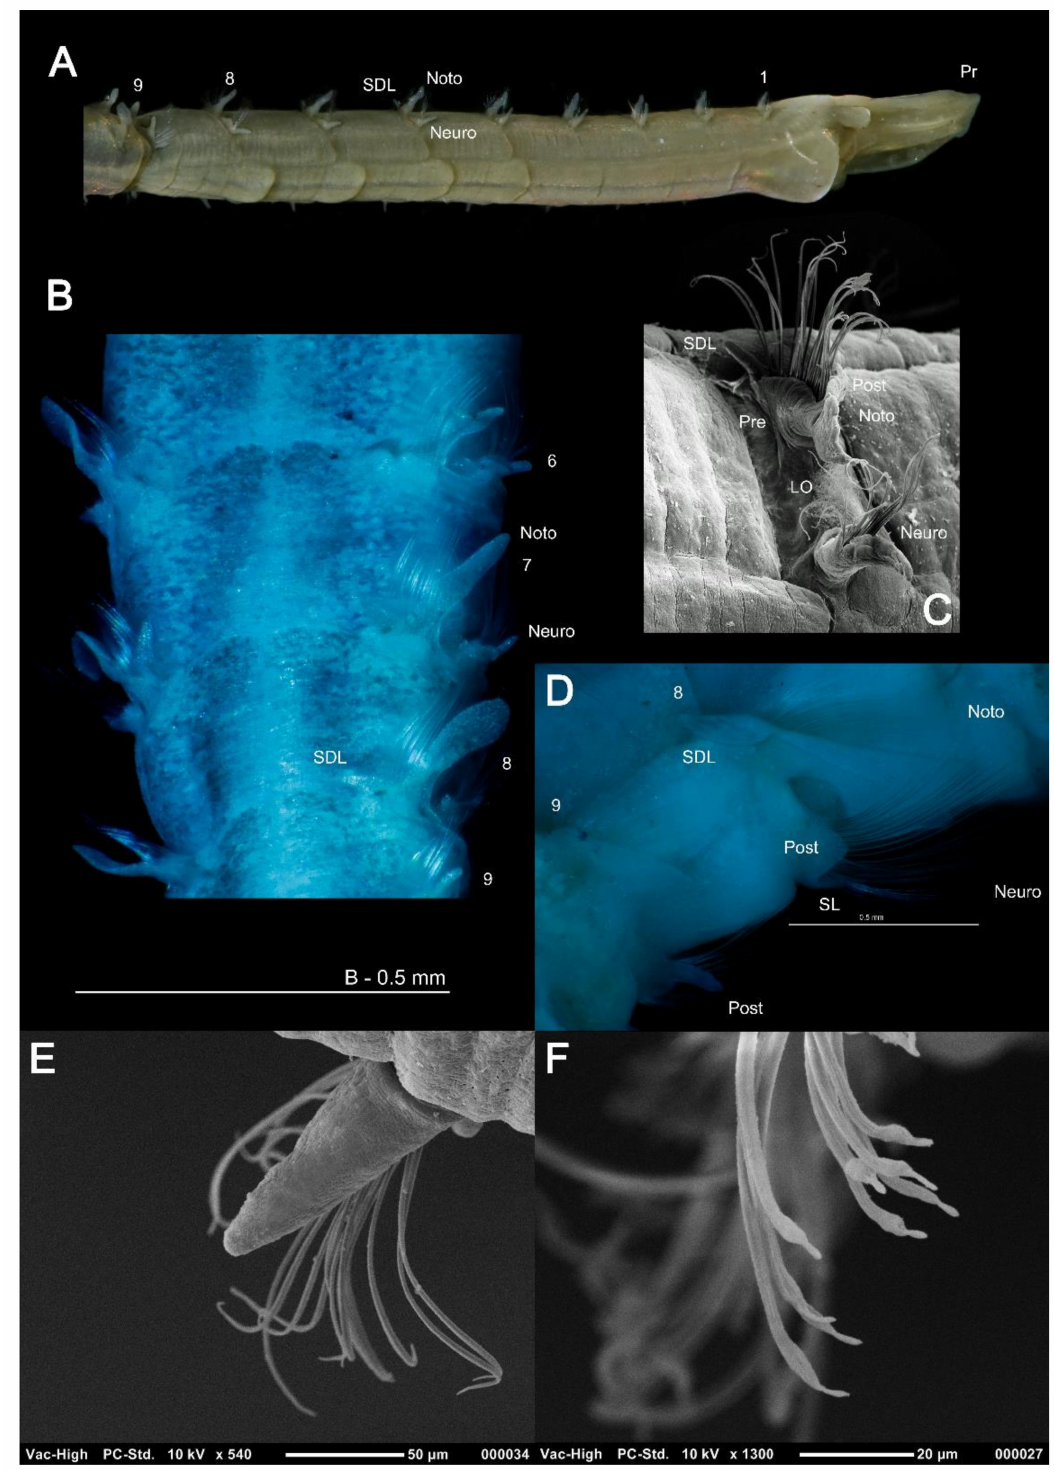
Figure 5. Thoracic parapodia and chaetae: ( A ) anterior of Magelona filiformis (lateral view) showing filiform lamellae; ( B ) M. crenulifrons from chaetiger 6–9 (dorsal view, stained with methyl green) showing foliaceous notopodial lamellae and superior dorsal lobes; ( C ) left-hand parapodia of chaetiger 8 of M. johnstoni (lateral view); ( D ) right-hand parapodia of chaetigers 8 and 9 of M. wilsoni ( E ) thoracic subchaetal neuropodial lamellae of M. johnstoni showing capillary chaetae; ( F ) mucronate capillary chaetae of chaetiger 9 of M. johnstoni . Abbreviations: LO—lateral organ, Noto—notopodia,